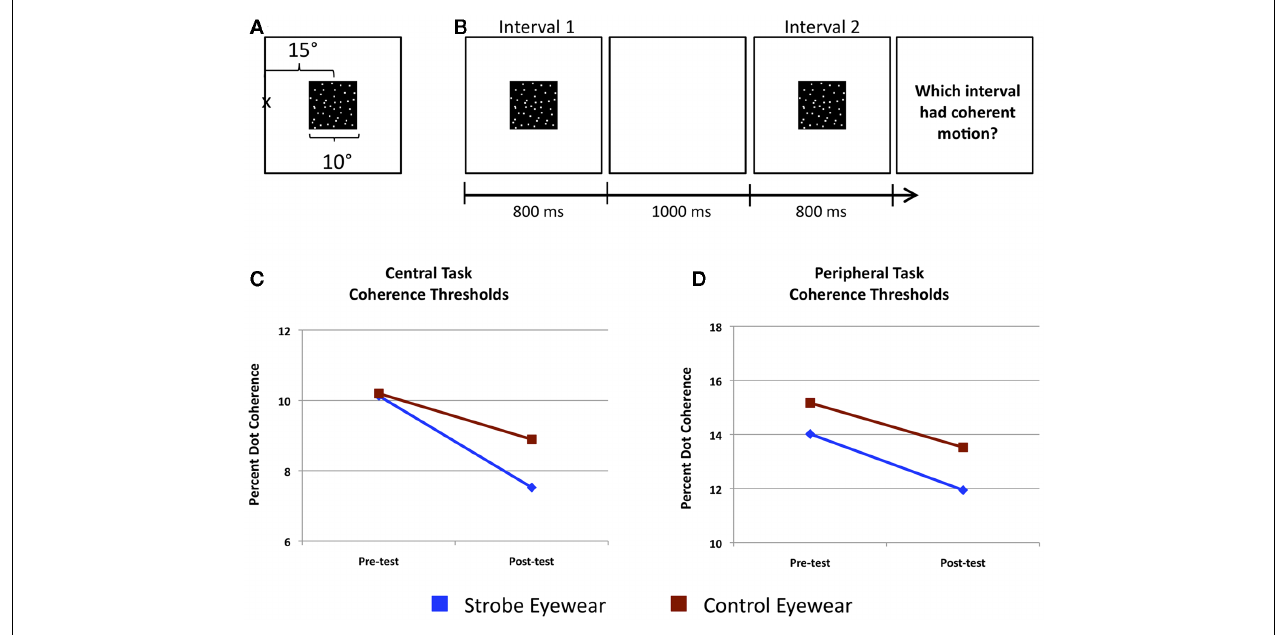
FIGURE 1 | Motion coherence task and results. Schematic illustration depicting (A) the relative size and position of the dot stimulus, and (B) the two-interval forced-choice procedure. Pre- to post-test motion coherence